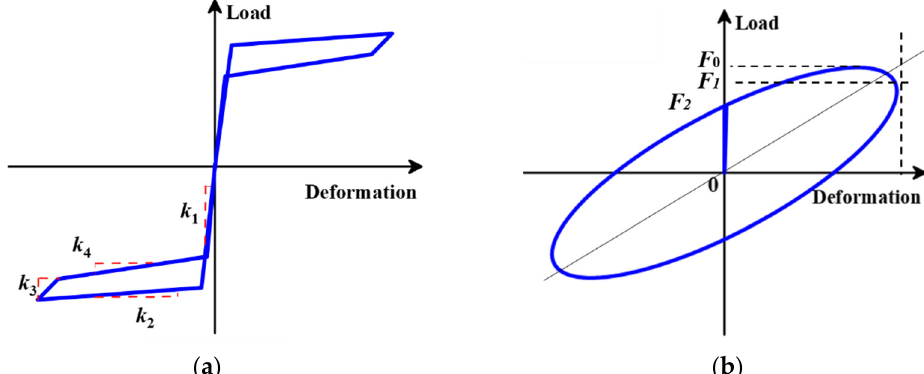
Figure 3. Illustration of hysteretic curves: ( a ) hysteresis model of SMA-based elements/components and ( b ) Kelvin–Voight model for viscoelastic materials.